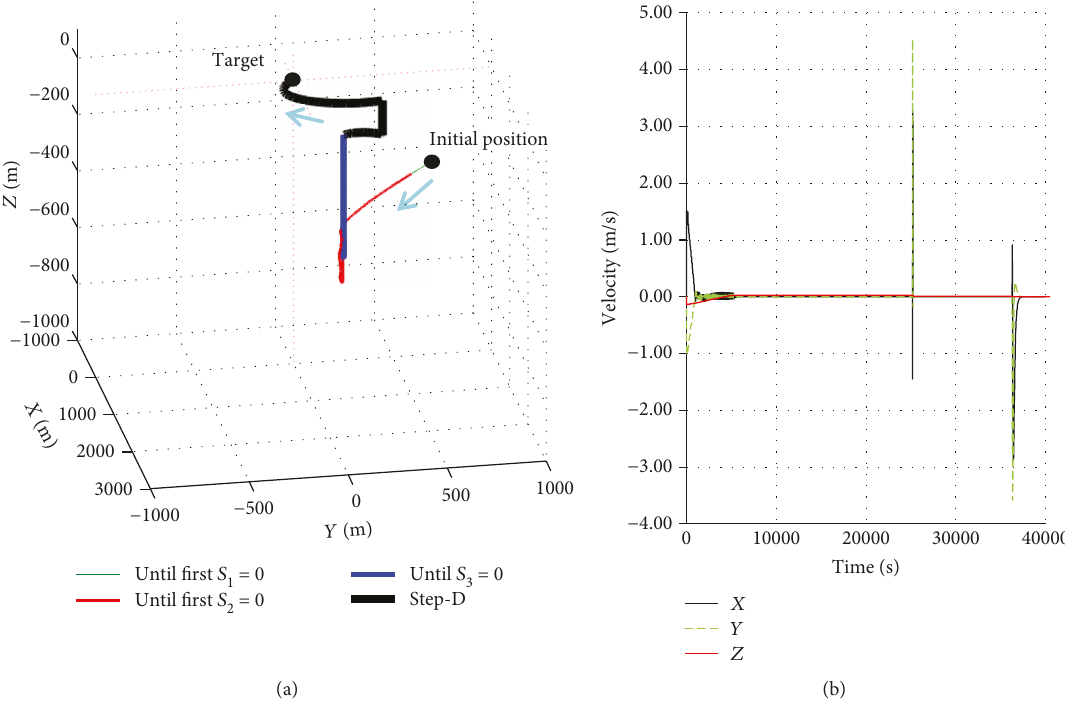
Figure 8: Position in case 1. (a) Position trajectory to the target. (b) Velocity histories.